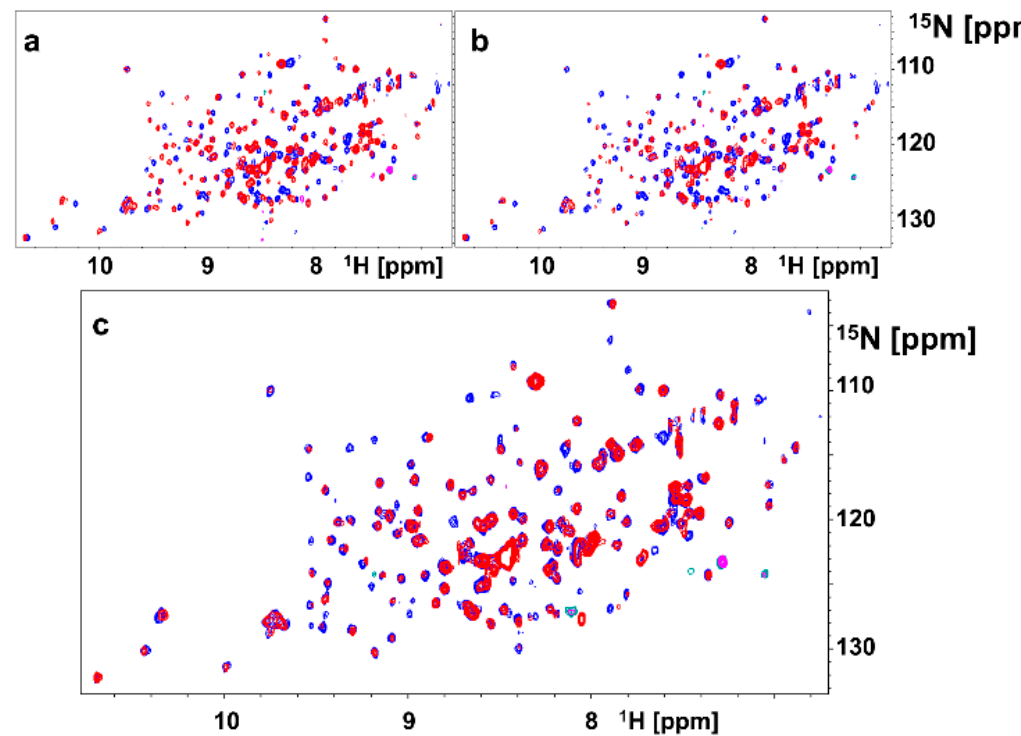
Figure 2. 2D NMR [ 15 N, 1 H] spectra with 15 N-labeled EphA2-LBD. ( a ) Superposition of 2D NMR spectra of EphA2-LBD (20 µ M), recorded in absence (blue) and presence (red) of 135G3 (20 µ M). ( b ) Superposition of 2D NMR spectra of EphA2-LBD (20 µ M), recorded in absence (blue) and presence (red) of 135G4. ( c ) Superposition of 2D NMR spectra of EphA2-LBD (20 µ M), recorded in presence of 135G3 (blue) or in presence of 135G4 (red).